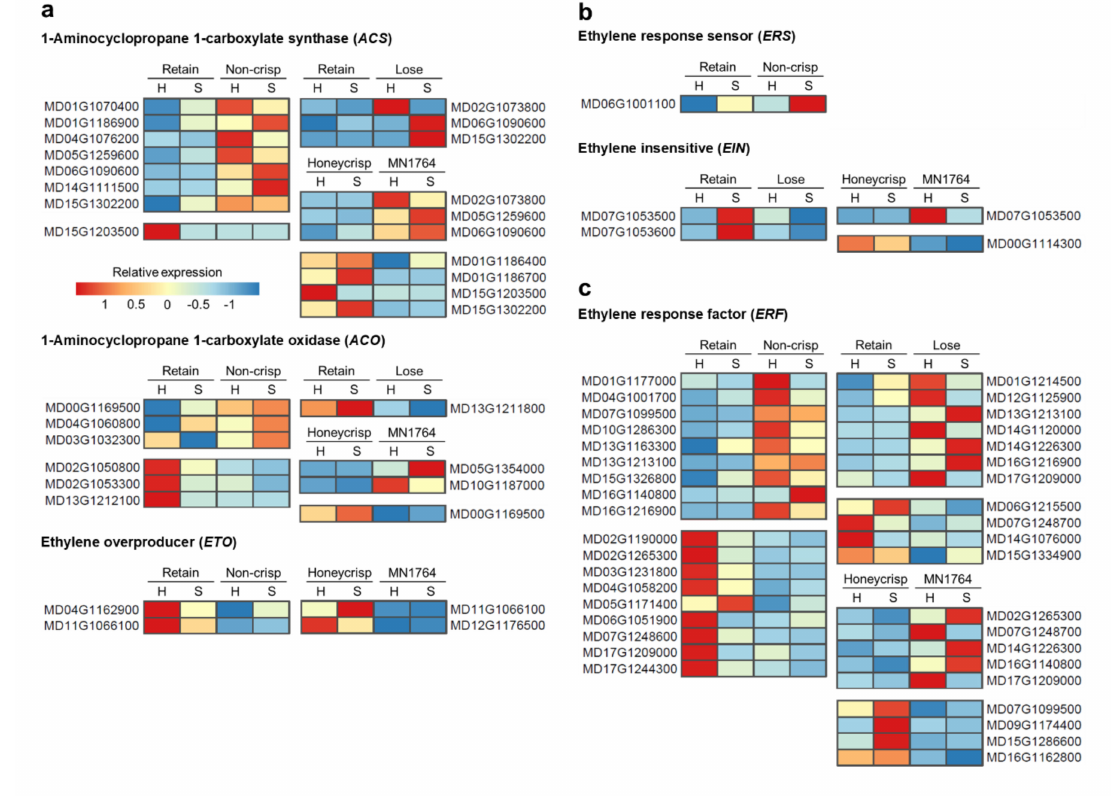
Figure 6. The expression patterns of the di ff erentially expressed genes (DEGs) involved in ( a ) ethylene biosynthesis, ( b ) signaling, and ( c ) response. The relative expression is the ratio of gene expression compared to the average. H = at harvest, and S = after 8-week cold